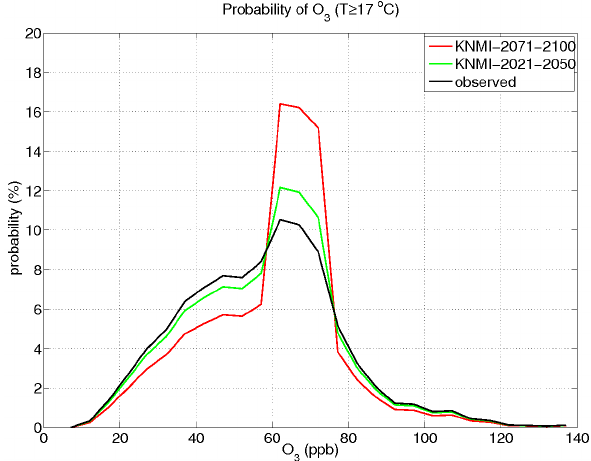
Figure 5. Ozone probability distributions for temperature above 17 ◦ C, for three periods, the observed (1990–1999) (black), the 2021–2050 (green) and the 2071–2100 (red). Values are plotted at the mid-point concentration of the 5ppb ozone concentration bin.